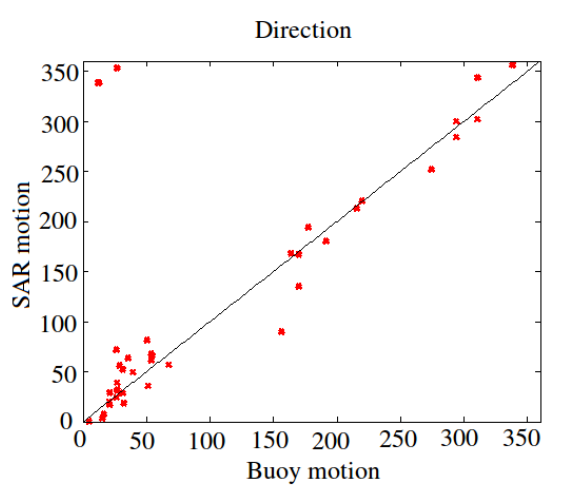
Fig. 9. Direction of the buoy motion and the estimated motion in degrees. The values correspond very well to each other. The high values of SAR drift directions for the low buoy drift directions are actually quite close to the buoy drift directions, because the direc- tion 0 degrees (to north) corresponds to the value 360 degrees.